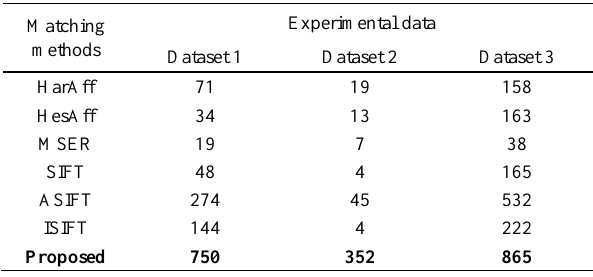
Table 1. Number of correct matches of different methods on the three datasets.